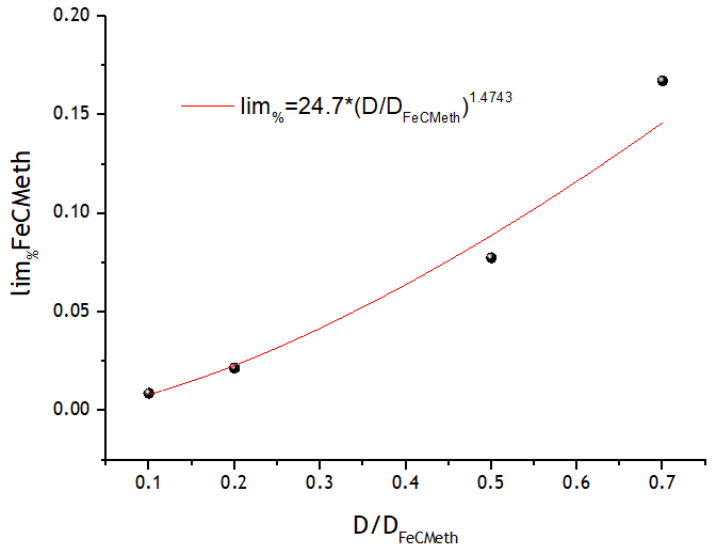
Figure 23. The dependence of the theoretical detection limit of a low molecular weight product in a mixture on the diffusion coefficient of a high molecular weight component.